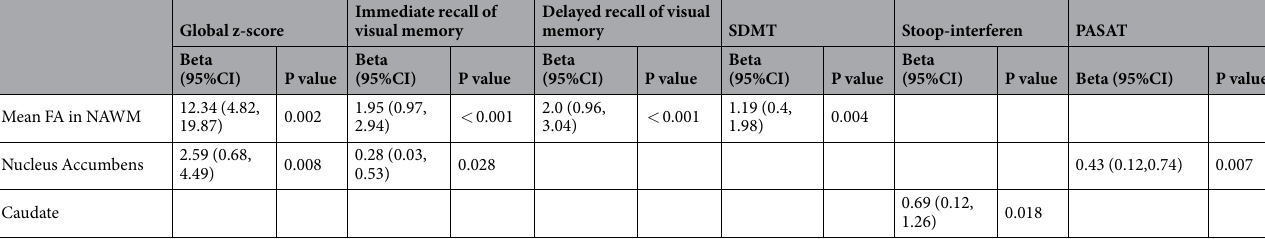
Table 5. Multivariate regression analysis to identify MRI variables associated with cognition. Abbreviations: FA = fractional anisotropy; NAWM = normal appearing white matter; PASAT = Paced Auditory Serial Addition Test; SDMT = symbol digit modalities test; 95%CI = 95% confidence